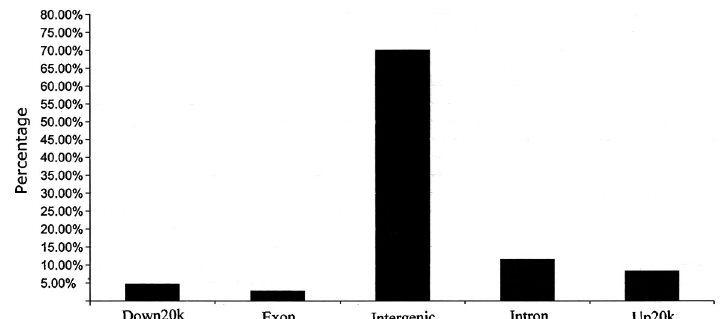
Figure 2. Genome-wide distribution of peaks relative to annotated genes.